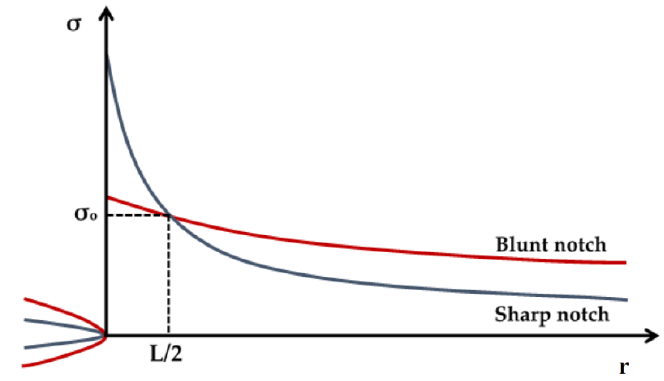
Figure 6. Obtaining theory of critical distances (TCD) parameters using the stress–distance curves.